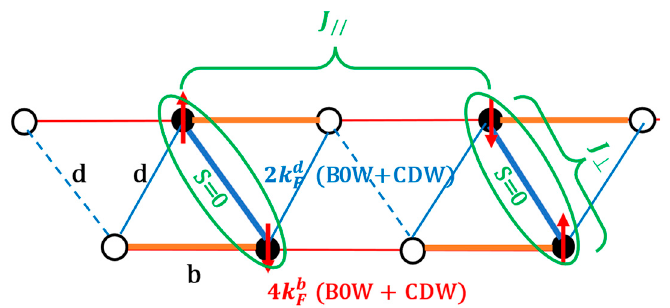
Figure 11. Schematic structure of the BOW and CDW in the quarter-filled zig-zag ladder combining 2k Fd modulation in zig-zag (blue) and 4k Fb modulation in stack (red) directions. Frustrated AF exchange interactions are indicated, as well as the location (in green) of spin singlets. Note that, in this figure, the centrosymmetric bond and charge patterns are kept for simplicity.